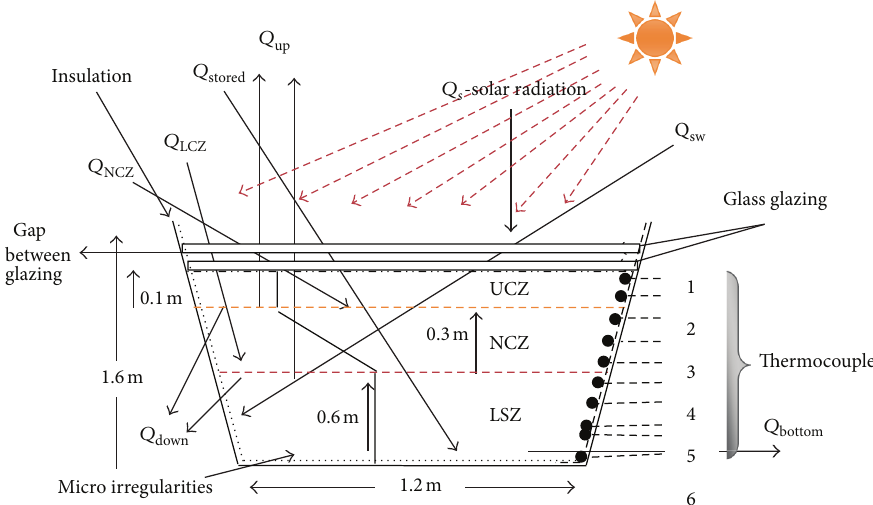
Figure 1: A schematic diagram of Shallow solar pond with rigid surface.